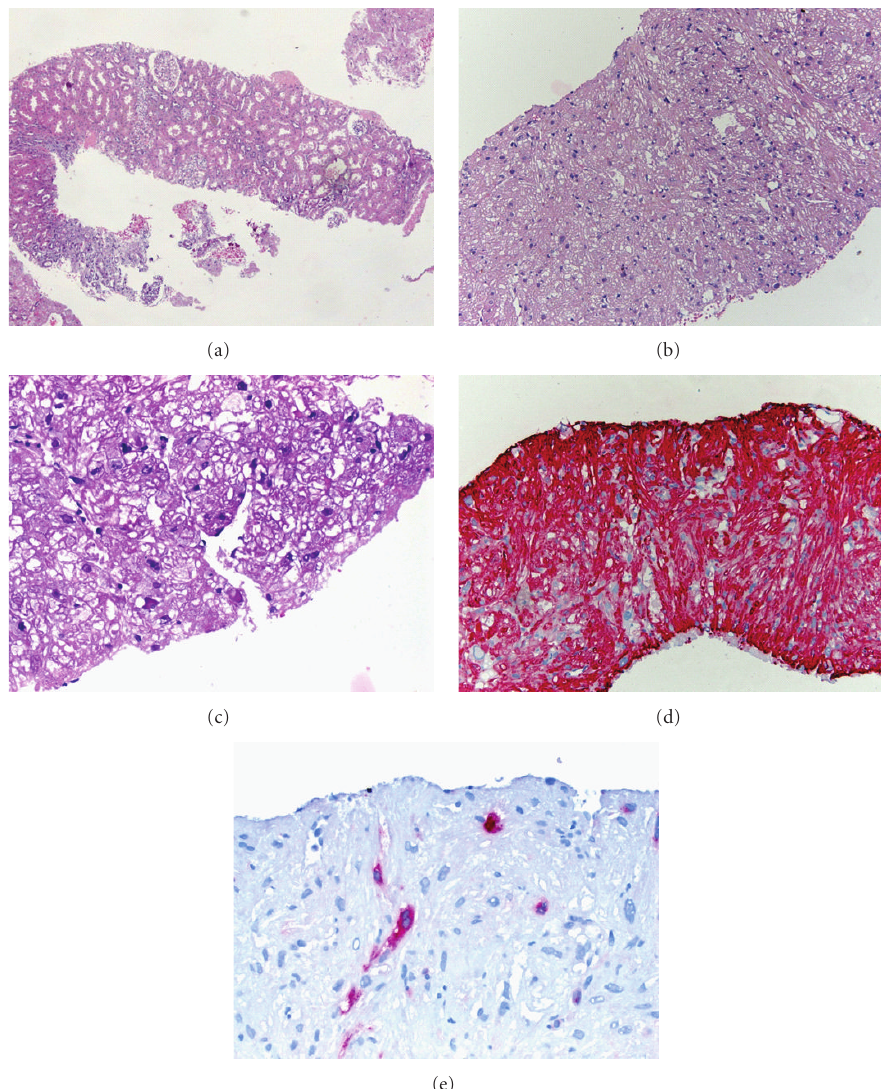
Figure 2: Representative findings of the kidney biopsy (a) with the angiomyolipoma (b–e). (a) Light microscopy of the kidney, hematoxylin stain (magnification × 4). (b) Light microscopy of the angiomyolipoma, hematoxylin stain (magnification × 100). (c) Higher magnification of the tumor showed large spindled and epithelioid cells with clear and eosinophilic cytoplasm intimately associated with slit-like vascular channels, (magnification × 400). (d) Immunohistochemistry using an antibody against actin (magnification × 100) shows a strong positivity of the smooth muscle component of the tumor. (e) Immunohistochemistry using an antibody against HMB-45 (magnification × 100) shows a few positive tumor